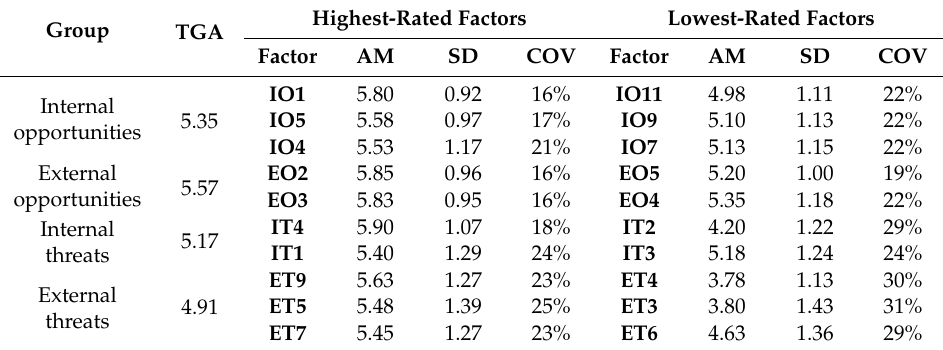
Table 7. Variability measures for factor assessment of the SWOT analysis, cont. Group